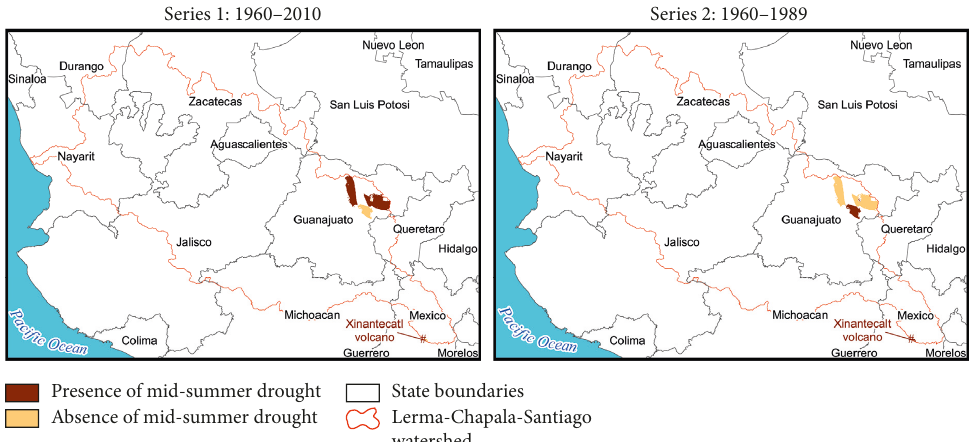
Figure 9: Areas of the watershed with changes in the presence or absence of mid-summer drought between time series one (1960–2010) and time series two (1960–1989).